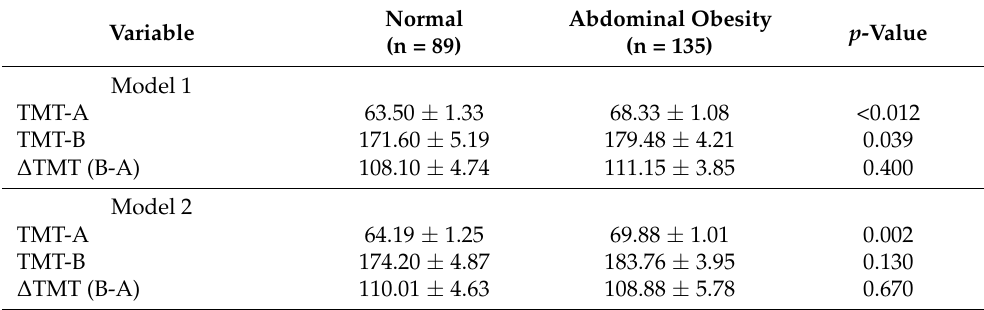
Table 4. Comparisons of executive function performance in waist circumference groups.